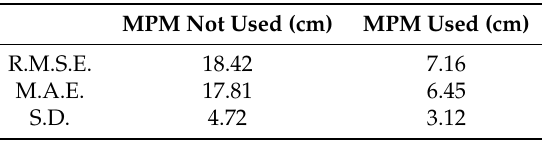
Table 2. Positioning error